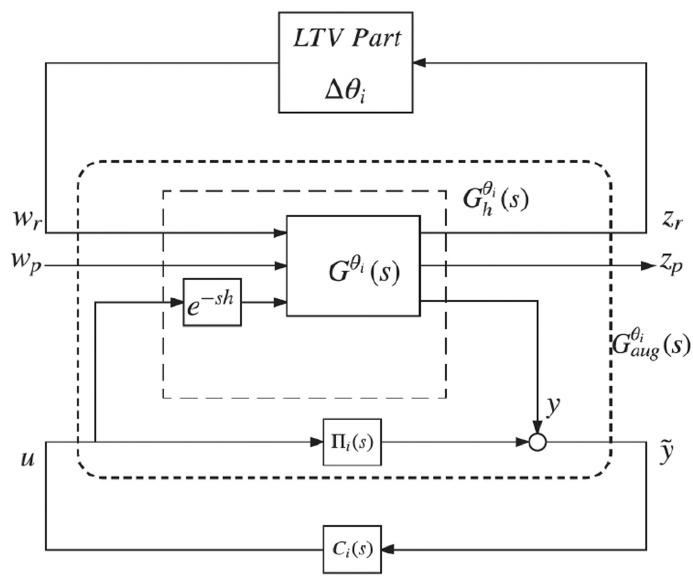
Fig 3. New representation of the system in Fig 2 added with Smith predictor-based